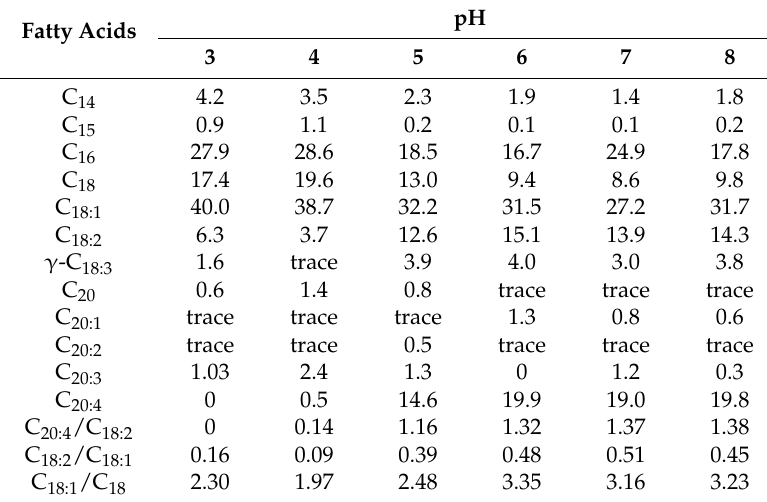
Table 4. The effect of pH on the fatty acid composition (% of lipids) of M. alpina NRRL-A-10995 in the stationary